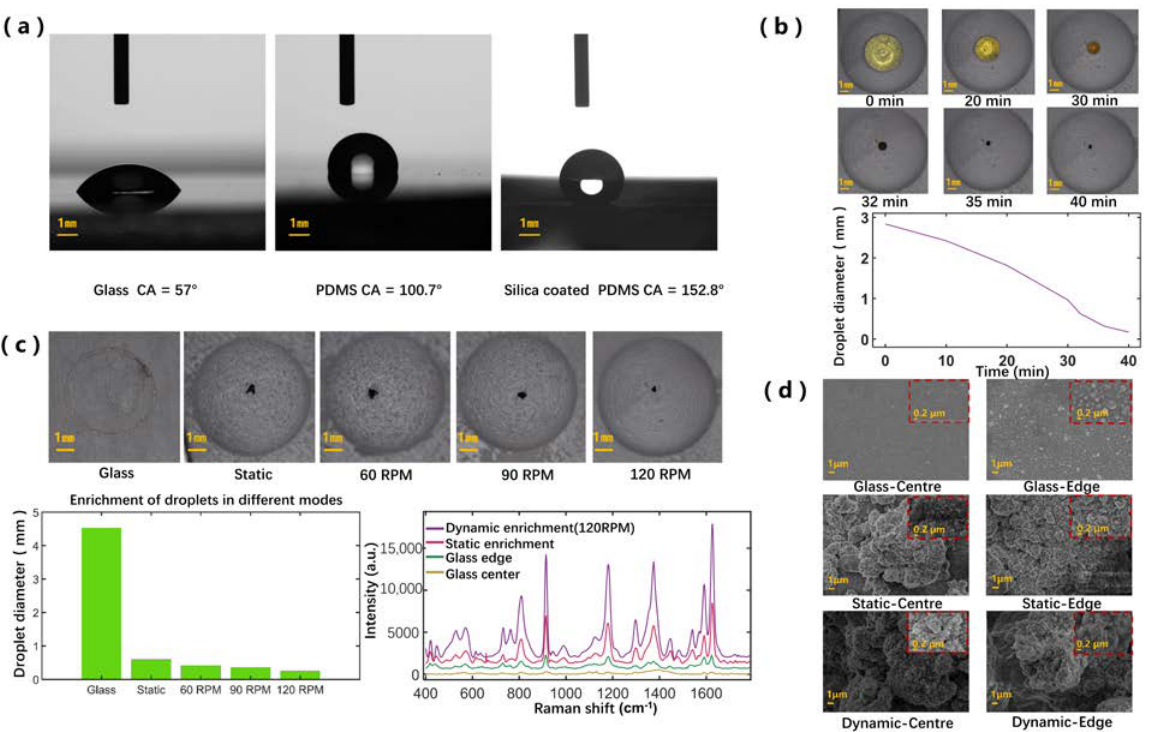
Figure 2. ( a ) Optical images of the 10 μL pure water droplet on different substrates showing different contact angles; ( b ) optical images and time-dependent curve showing the volume change of the droplet, containing 13 μL droplet during rotary evaporation at a spinning speed of 120 RPM; ( c ) optical images, related histogram, and SERS signals for the evaporation-ended droplet on glass and on SCDA spun at different speeds; ( d ) SEM images of droplets vaporized on different substrates and at different locations.